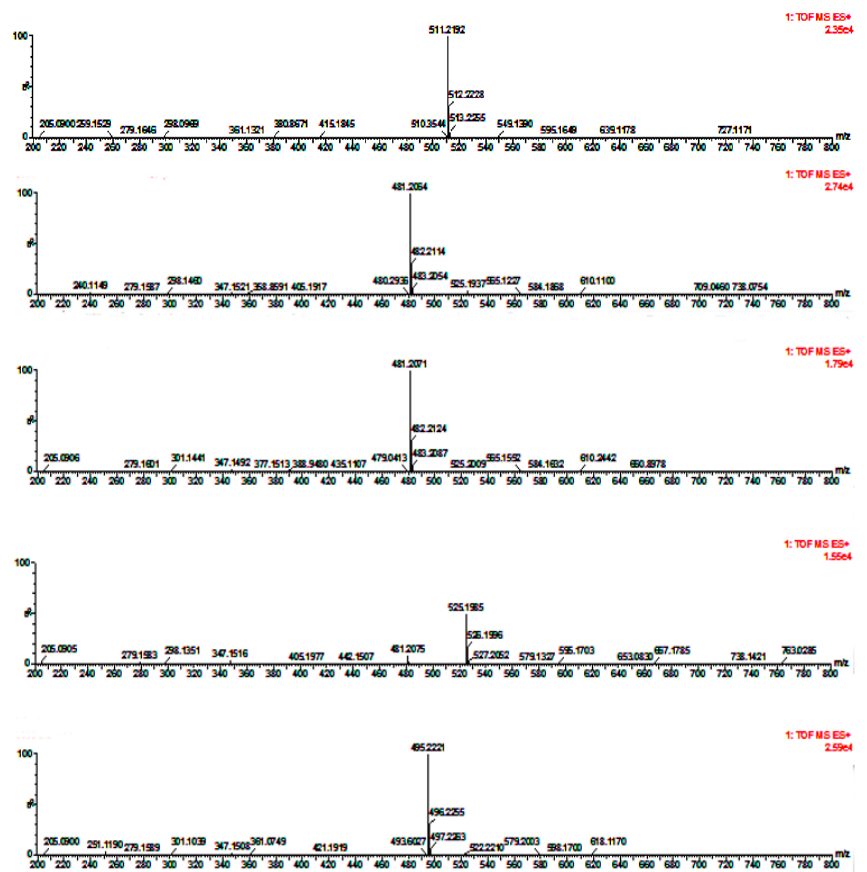
Figure 3. Mass spectra of reference monosaccharides (from the top to the bottom they are mannose, glucose, xylose, arabinose, glucuronic acid and rhamnose, respectively).